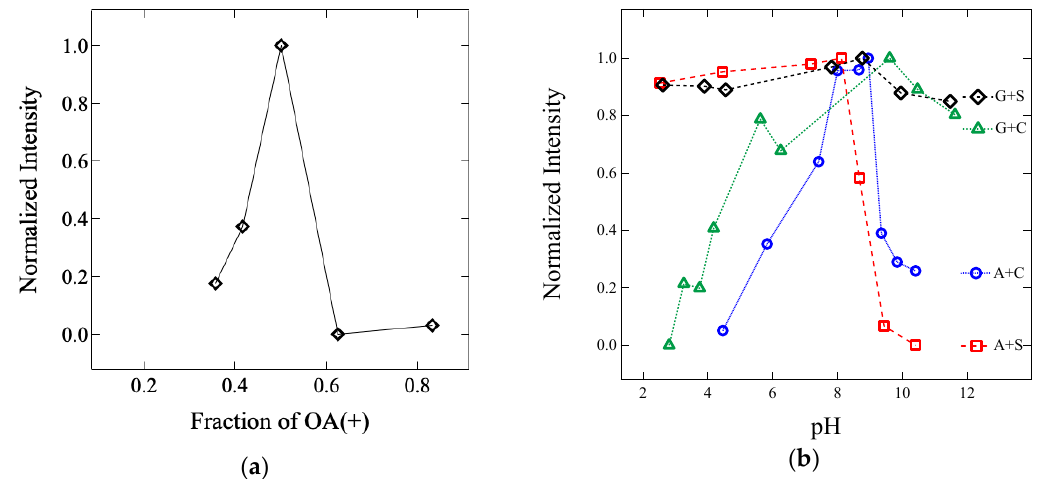
Figure 2. Normalized light scattering intensity with an angle of 90° as a function of ( a ) the fraction of cationic block copolyelectrolyte of G + S at pH of 7 and ( b ) pH of the solution at 1:1 mole ratio of A + S (square, red), A + C (circle, blue), G + S (diamond, black), and G + C (triangle, green) in an aqueous solution (color online).